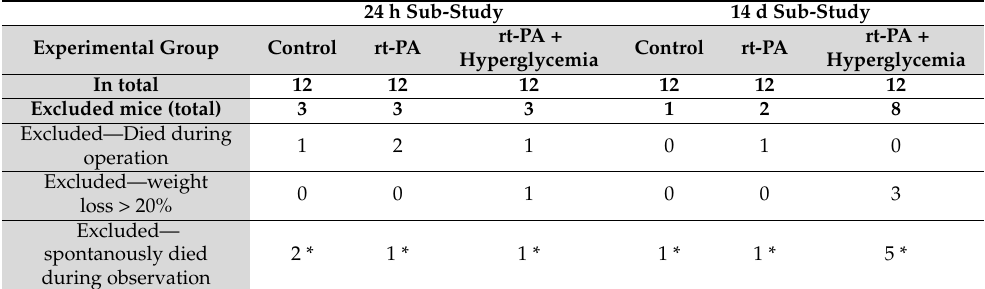
Table 1. Inclusion and